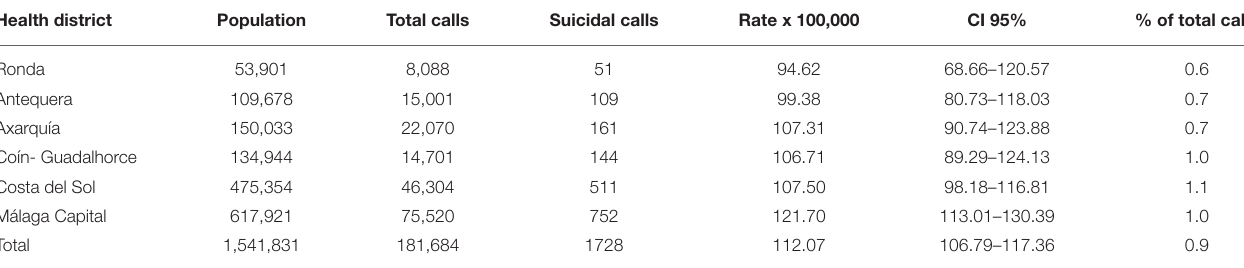
TABLE 3 | Distribution of the suicidal behavior calls made to the Prehospital Emergency Service by health district. Health district